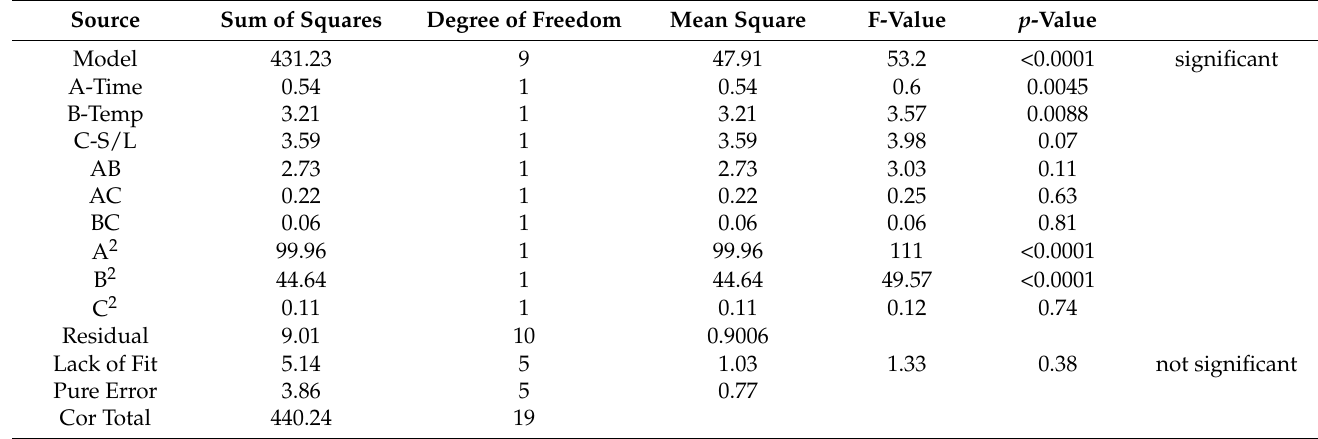
Table 3. ANOVA for a fitted quadratic model of extraction conditions with yield